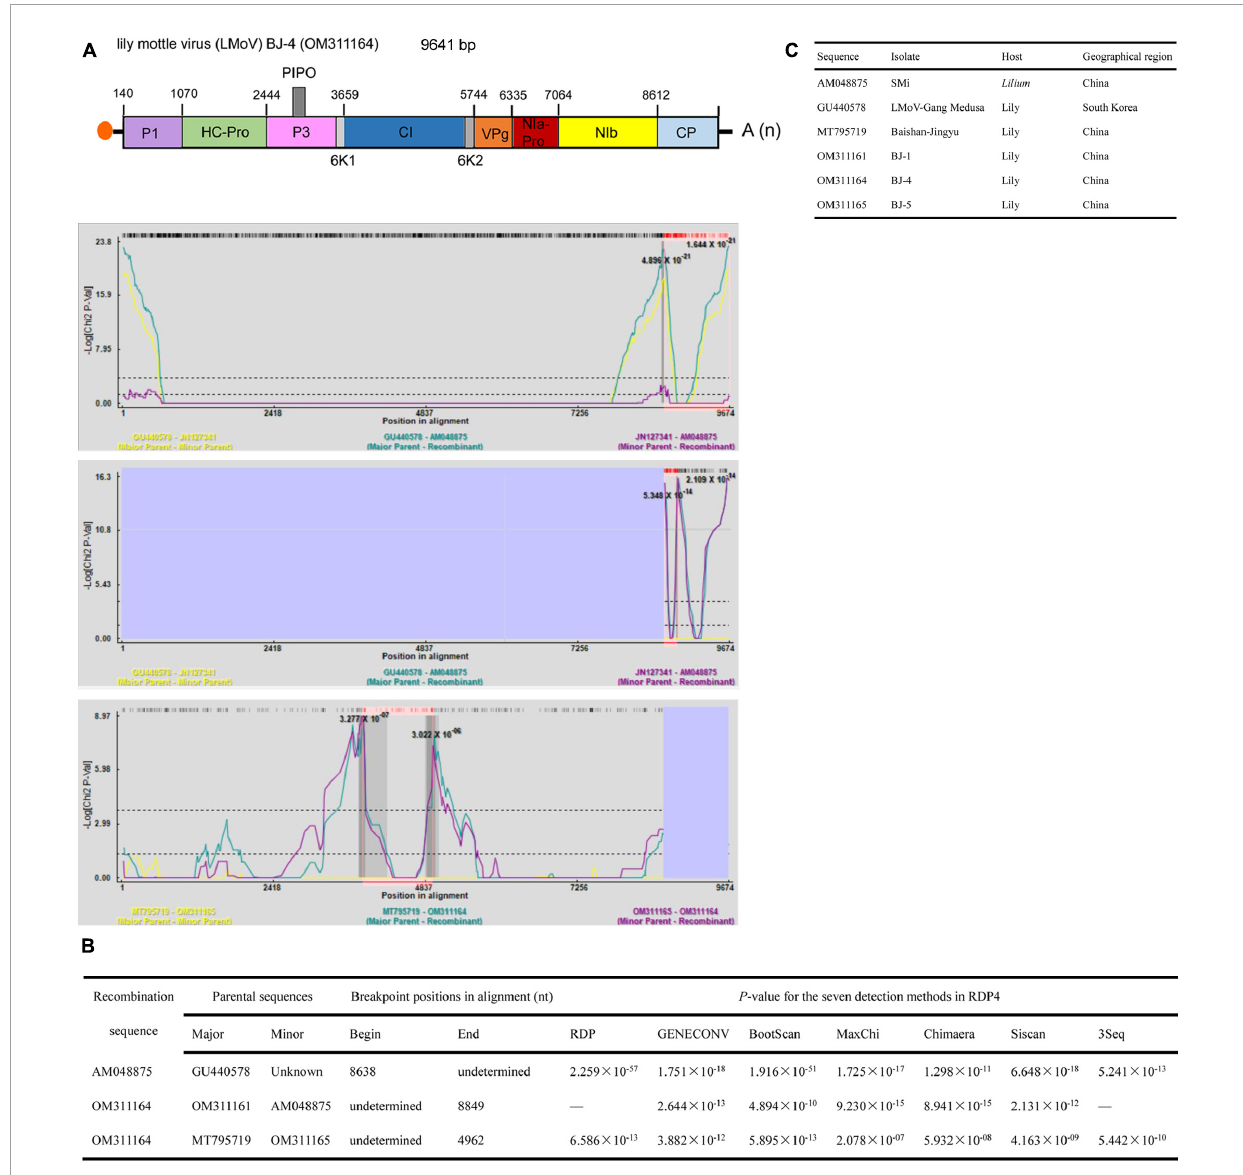
FIGURE6 Recombination in the genomic sequences of LMoV analyzed using RDP4. (A) Schematic representation of the predicted recombinant LMoV BJ-4 and the MaxChi plots of the recombinants detected by the RDP4 software. (B) The relevant information of three predicted recombination events of LMoV genomes. (C) The hosts and geographical regions of major and minor parents of the three LMoV recombinants. Major parent, parent contributing larger fraction of sequence; minor parent, parent contributing smaller fraction of sequence; unknown, only one parent and a recombinant need be in the alignment for a recombination event to be detectable. The sequence listed as unknown was used to infer the existence of a missing parental sequence. —, no significant. P -value was recorded for this recombination event using this